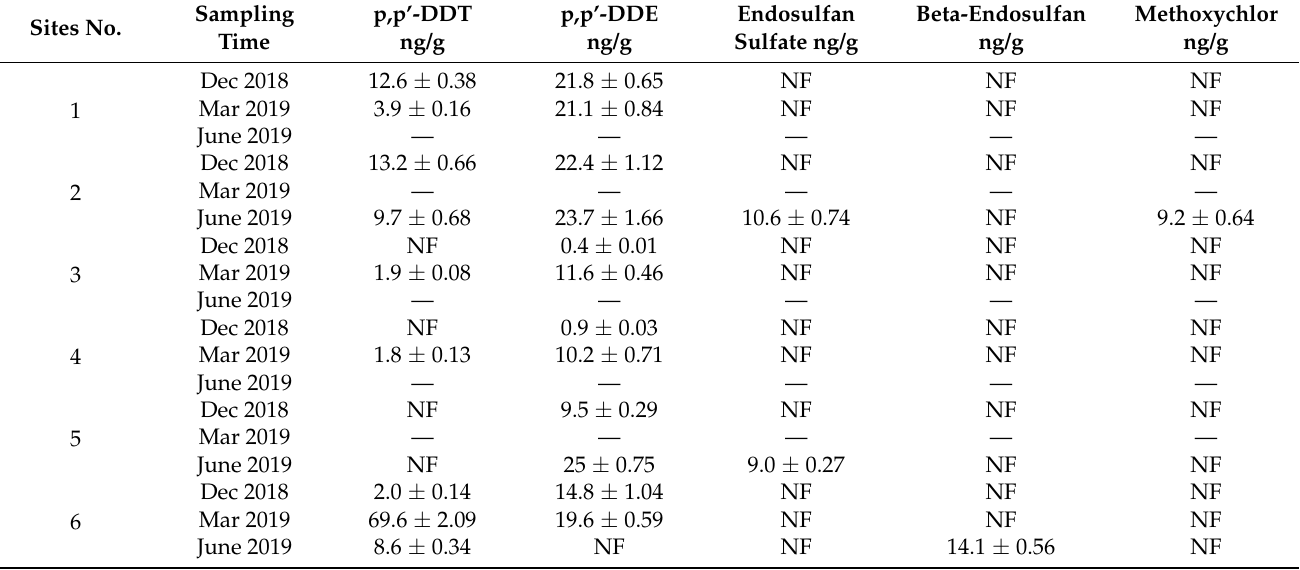
Table 4. Distribution characteristics of OCPs in surface sediments of water